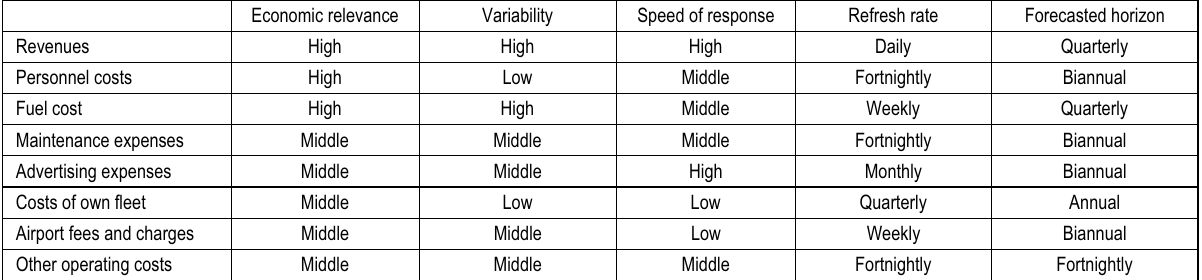
Table 4. Measures and periods Southwest Airlines uses for performing rolling